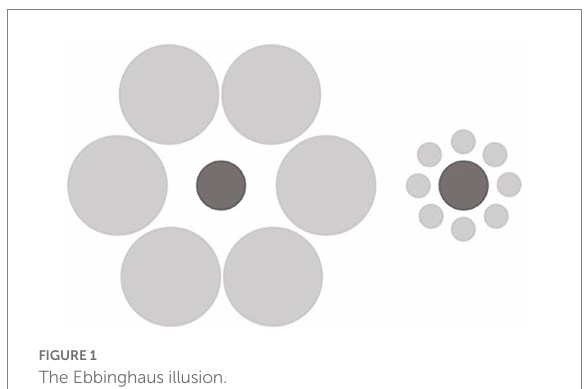
FIGURE 1 The Ebbinghaus